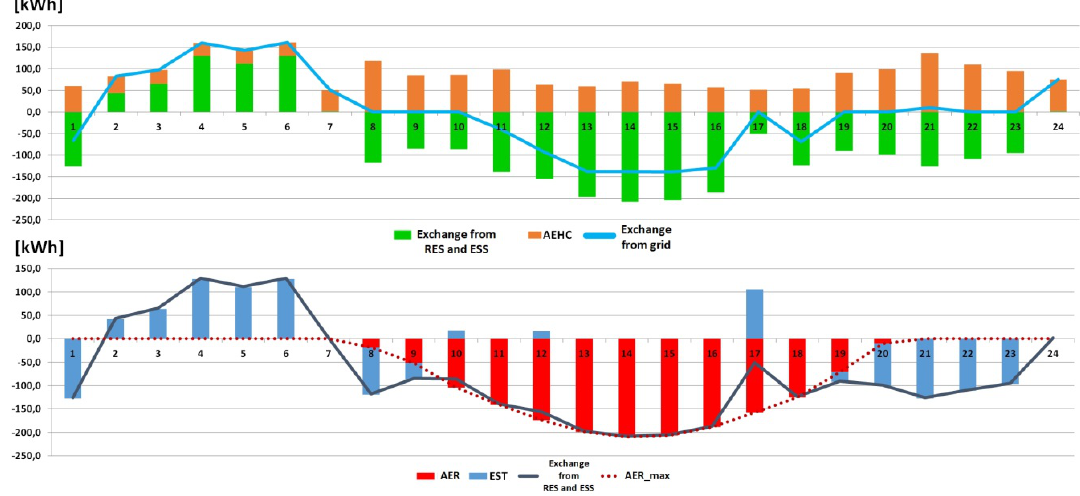
Figure 11. Energy management during the simulation day under the FiT scheme, with an energy storage system (ESS) configuration.